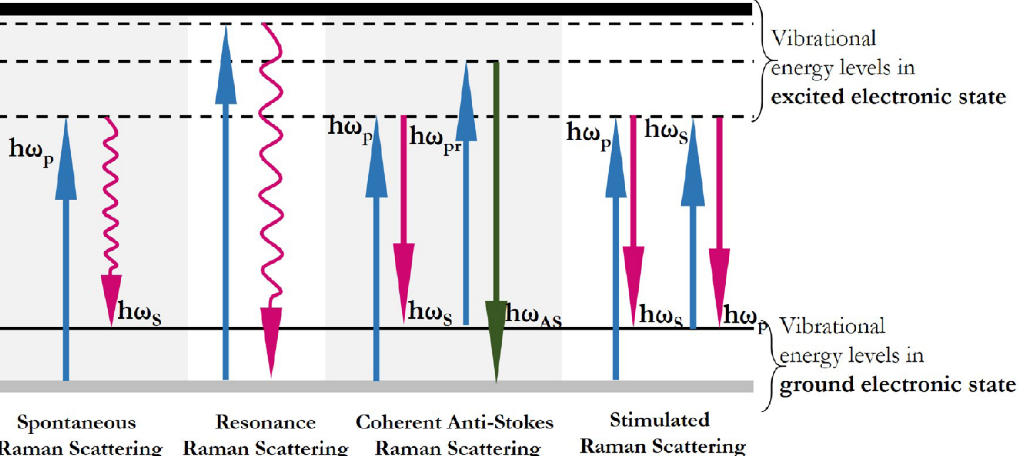
Figure 1. Energy level diagram demonstrating the Raman, RRS, CARS, and SRS